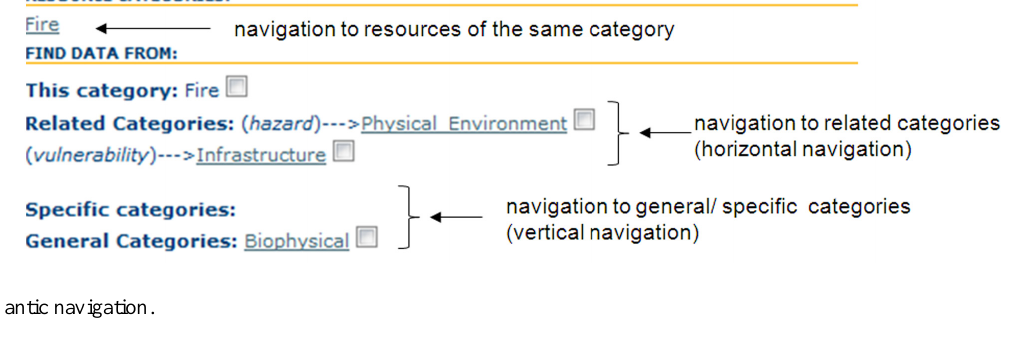
Fig. 7. Semantic navigation.